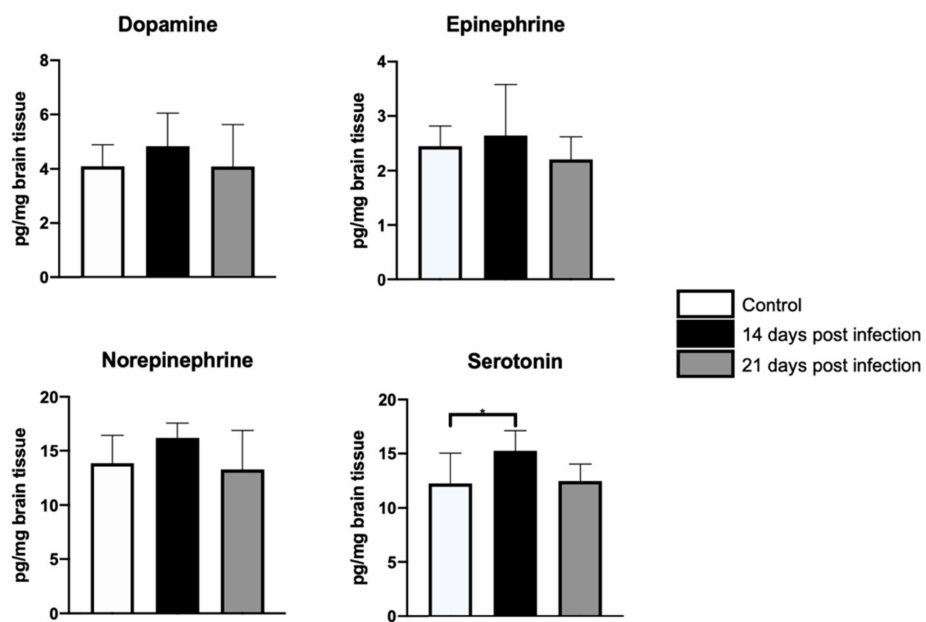
Figure 2. Neurotransmitter concentration in cerebellum. HPLC analyses revealed a transient, significant increase in cerebellar serotonin levels in infected mice when compared with control mice at day 14-PI. ANOVA tests were used in all cases, except for dopamine, for which Kruskal–Wallis tests were employed. Statistical significance was recognized when p < 0.05. Statistical significance is represented as follows: * p < 0.05.